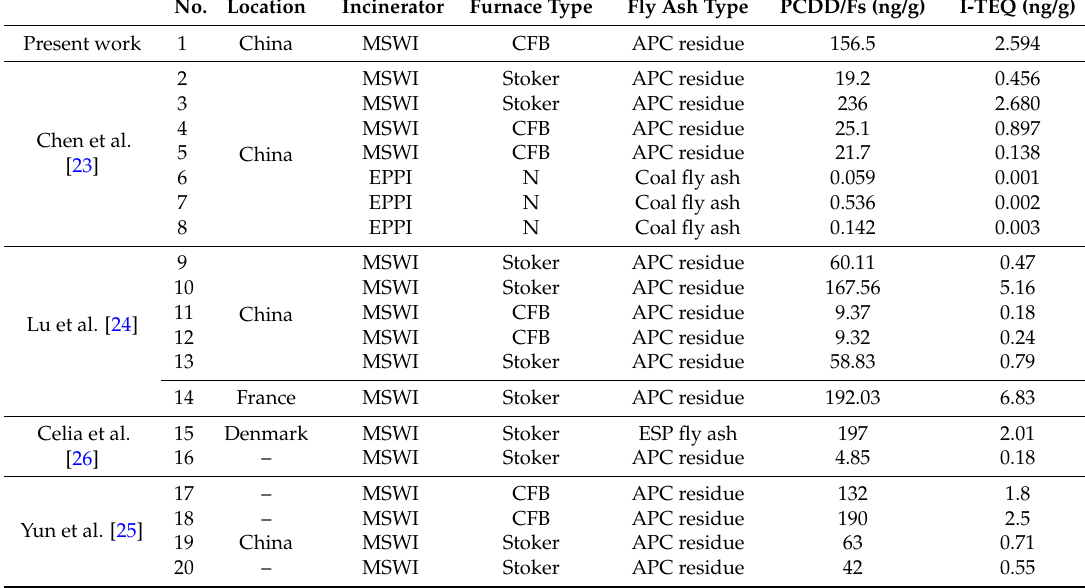
Table 5. The concentration of PCDD/Fs in different fly ashes from different incinerators.